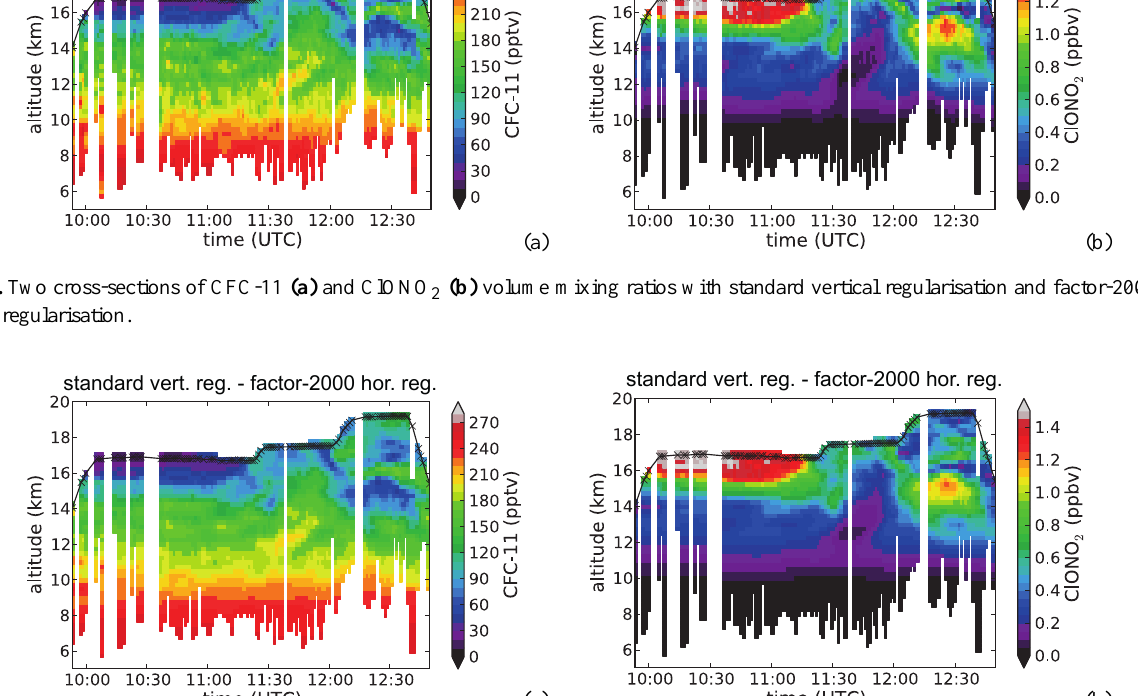
volume mixing ratios with standard vertical regu- 2